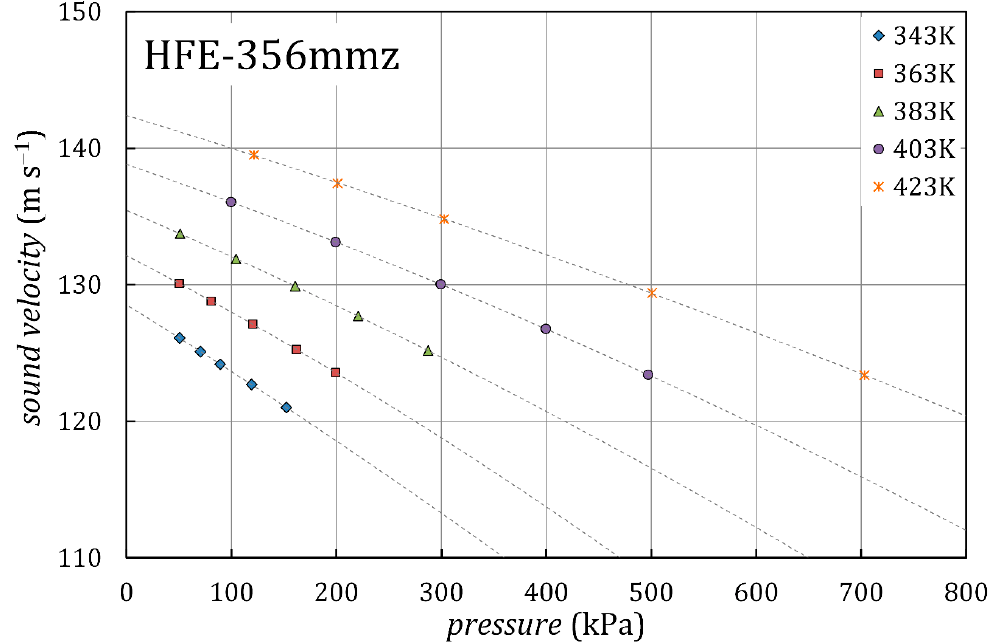
Figure 2. Sound velocity data on five isotherms for HFE-356mmz.